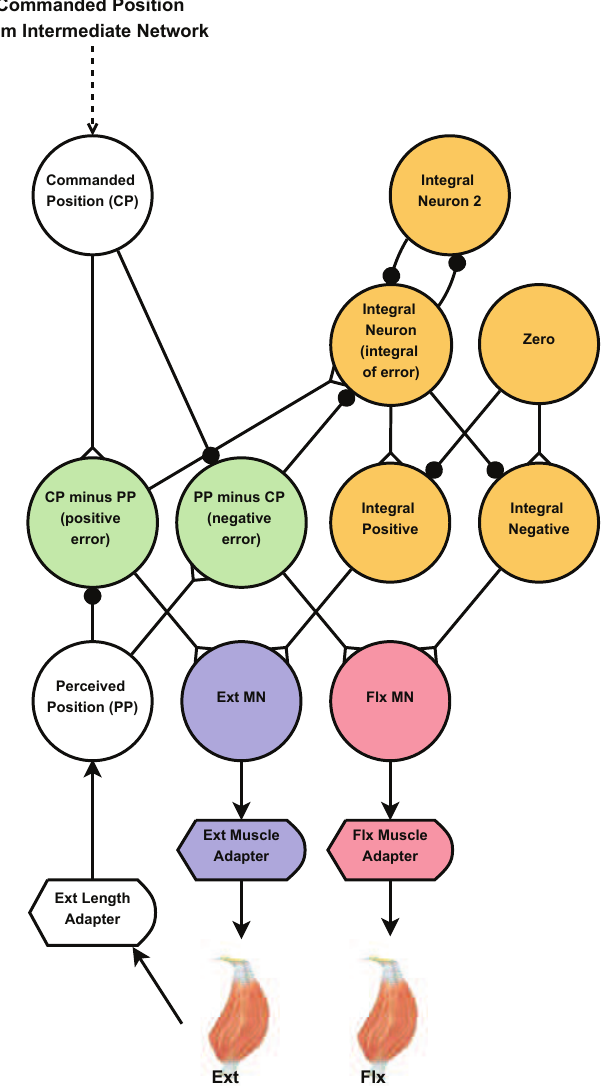
Figure 4. Diagram of the joint control network. Joint angles are linearly mapped to neuron voltage. The commanded position (CP) neuron input signal comes from the intermediate network. The perceived position (PP) neuron input signal is mapped from the length of the extensor. The CP and PP neuron voltage’s are subtracted from each other to create two “error” neurons (green). Only one of these neurons can be active at a time. The error neurons excite the appropriate muscle motor-neuron, acting in a very similar way to the proportional part of a standard PID controller. The error neurons are also used as an input to the integral part (orange). The integral part continues to adjust the appropriate motor-neuron (MN) until the voltage of the CP and PP neurons match. Synapses with black circles and white triangles represent inhibitory synapses and excitatory synapses,